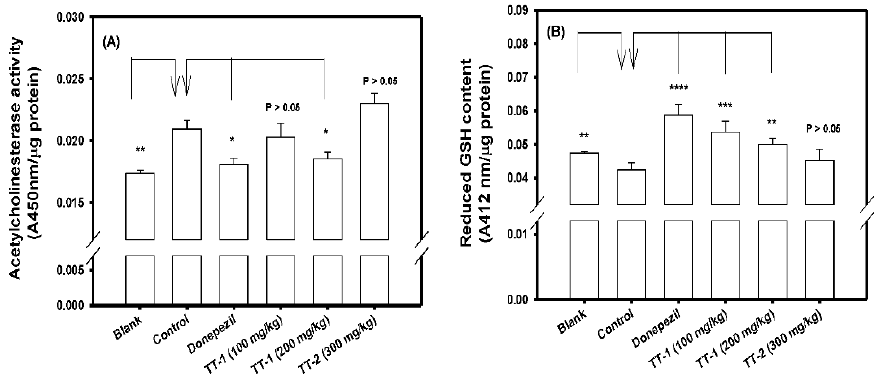
Figure 6. Effects of TT-1 (100 and 200 mg/kg) or TT-2 (300 mg/kg) treatments on ( A ) acetylcholinesterase activity; ( B ) reduced form glutathione (reduced form GSH) contents in brain extracts of the experimental mice. The mice in the control group were injected with scopolamine only (the protocol of the Figure 5A). The quantitative data were presented as mean ± SD of three independent experiments. Student’s t-test was used to compare treated groups with the control group, and any difference was considered statistically significant when p < 0.05 (*), or p < 0.01 (**), or p < 0.001